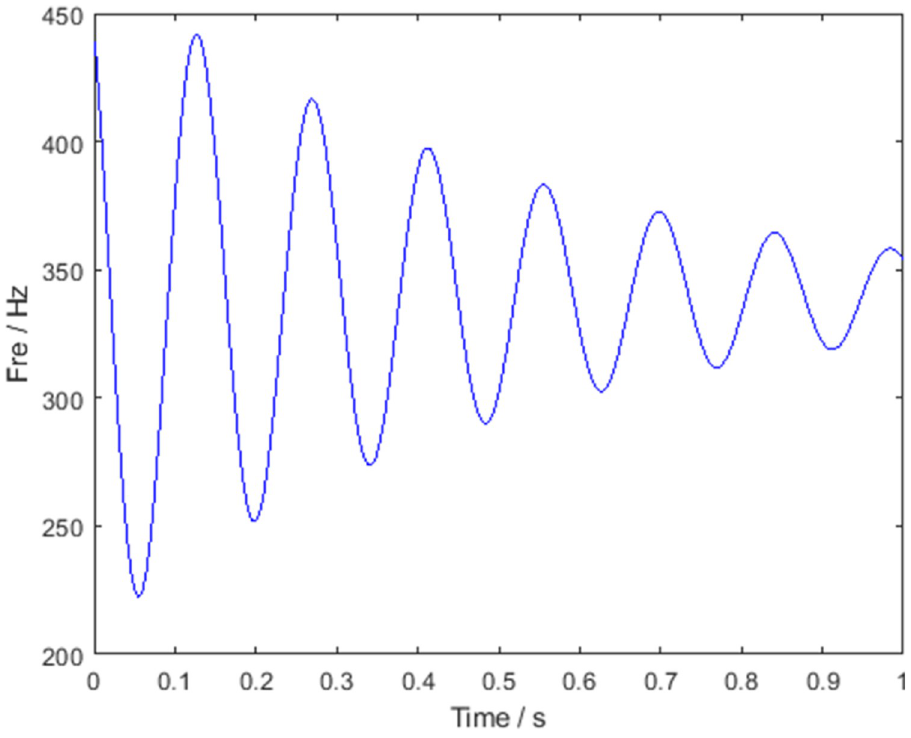
Fig 1. Ideal instantaneous